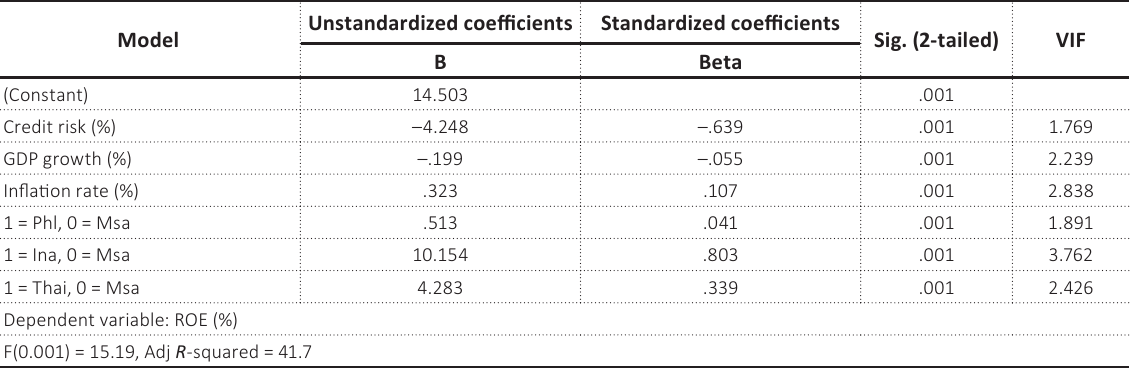
Table 7. Regression results on